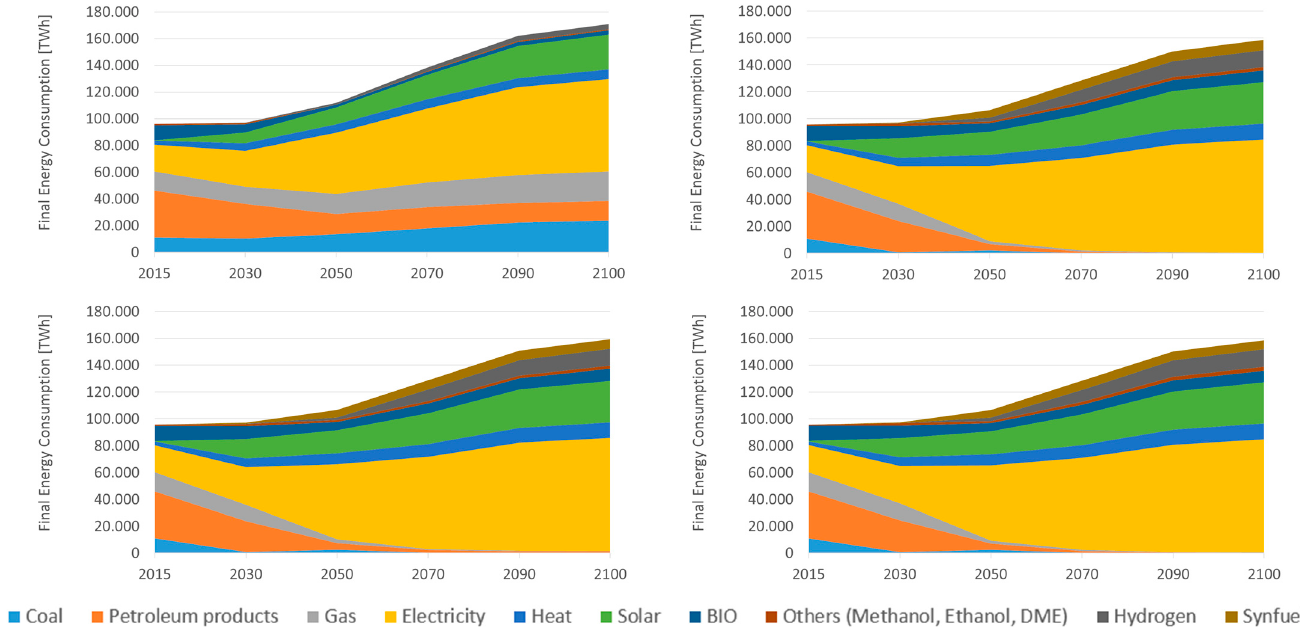
Figure 6. Global final energy consumption along all scenarios. BAU is top left, 1_5D is top right, SoS1 is bottom left and SoS2 is bottom right.